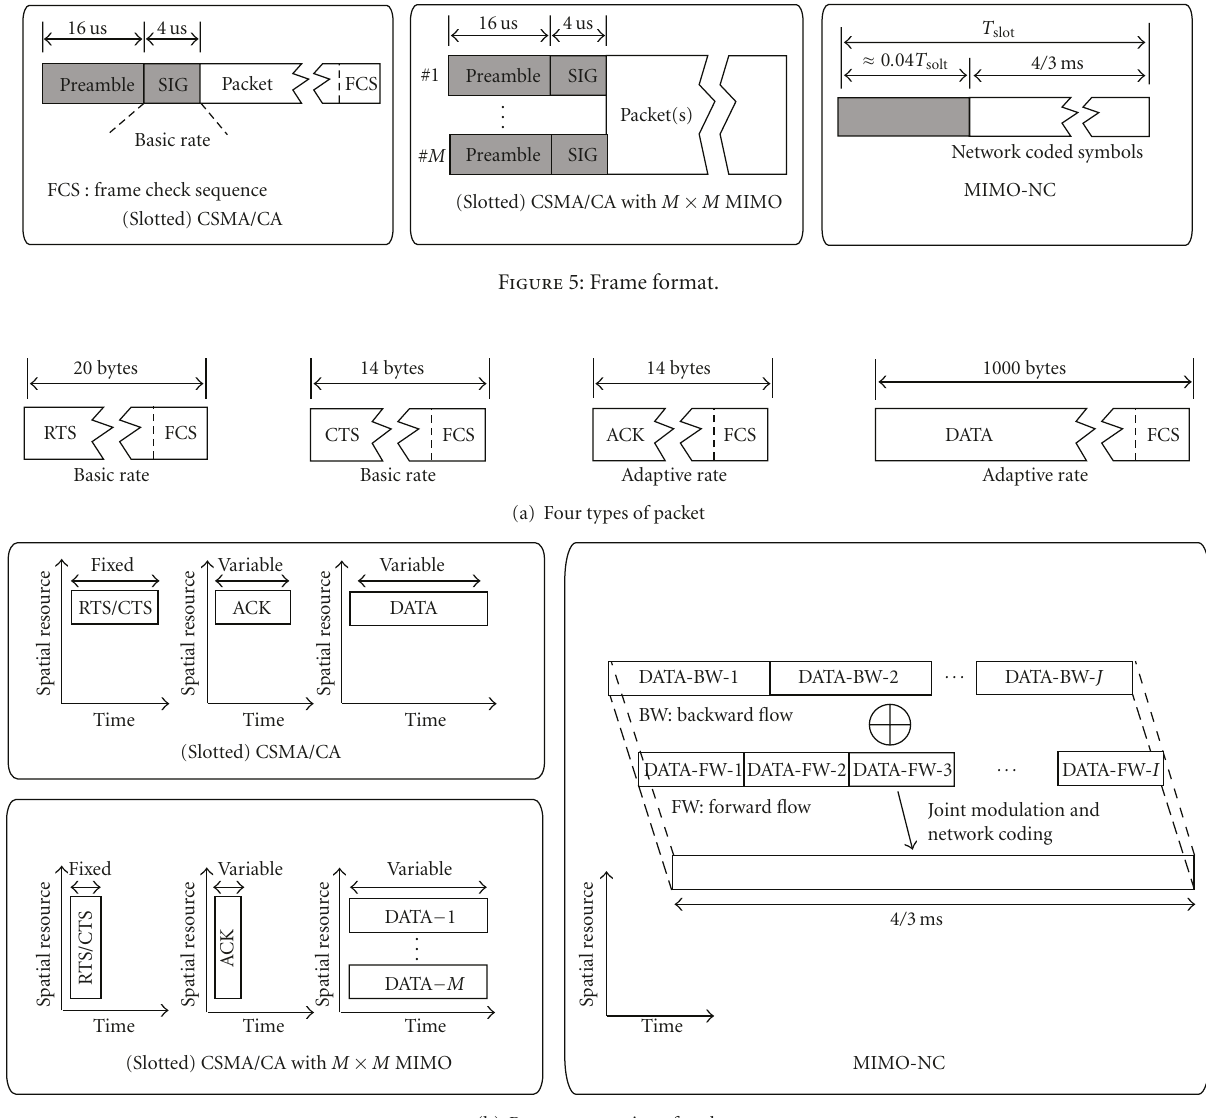
Figure 6: Resouce mapping of di ff erent types of packet used in network